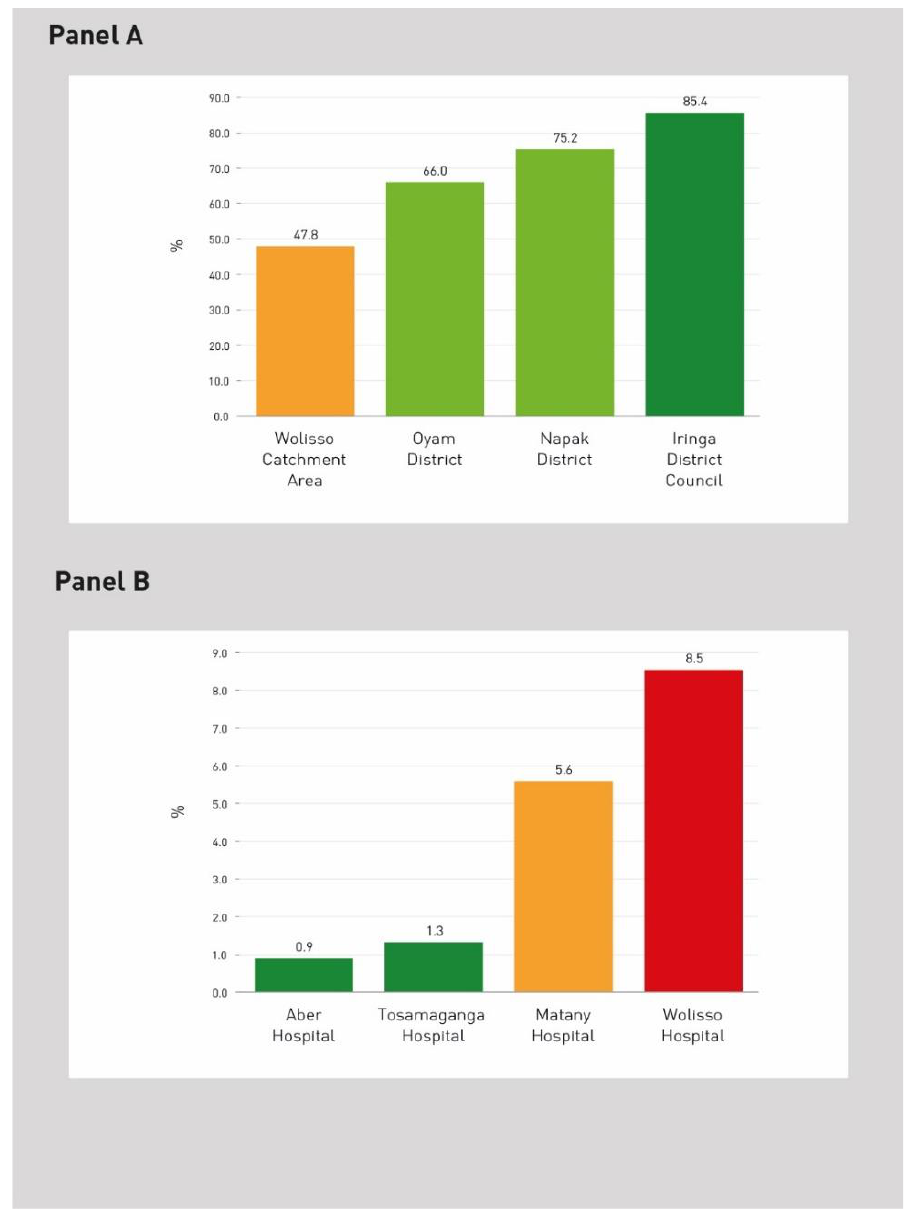
Figure 1. Two examples of evaluated indicators at hospital and district level. (A) Proportion of pregnant women who attended ANC4+ during the current pregnancy; (B) Percentage of discharged patients for diarrhoea and gastroenteritis.